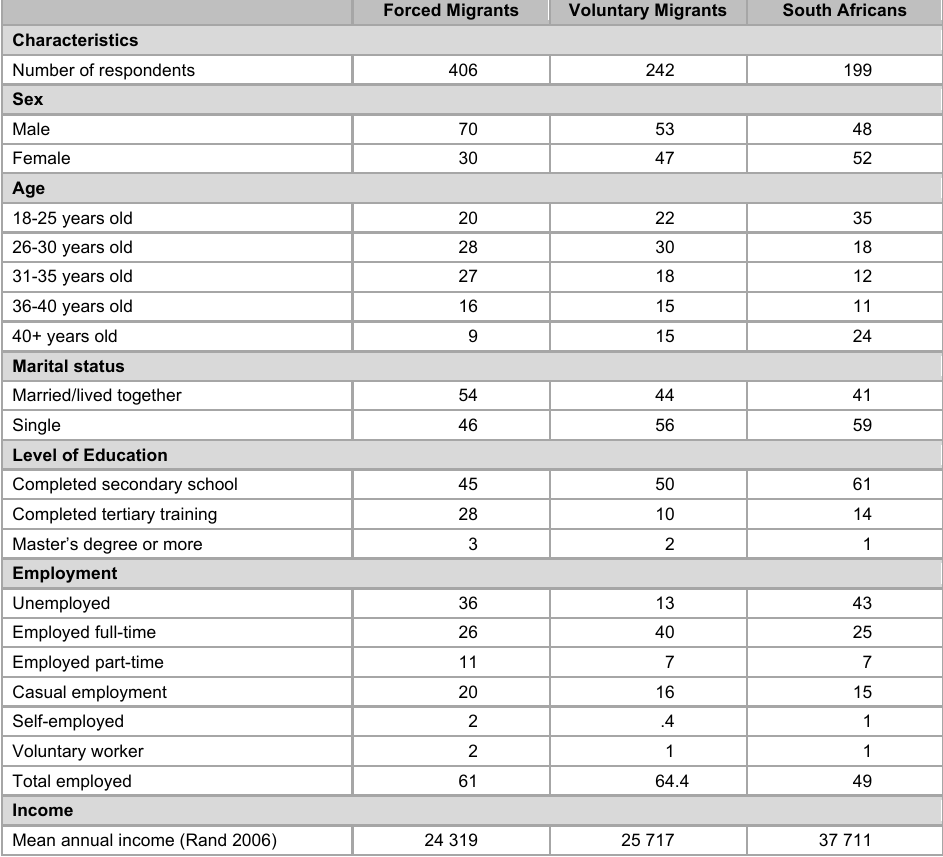
Socio-economic and demographic characteristics (percentage of selected group, except if specified otherwise) Forced Migrants Voluntary Migrants South